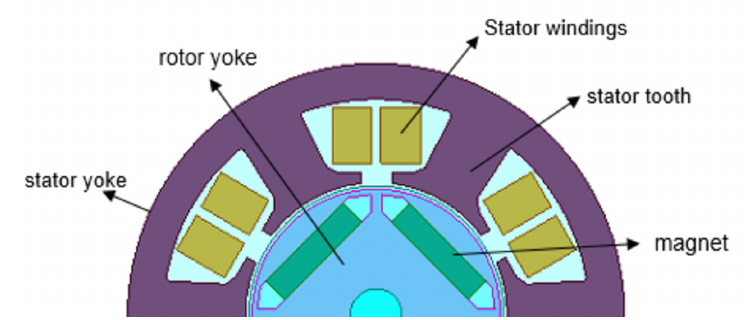
Figure 9. Half of IPMBLDC motor